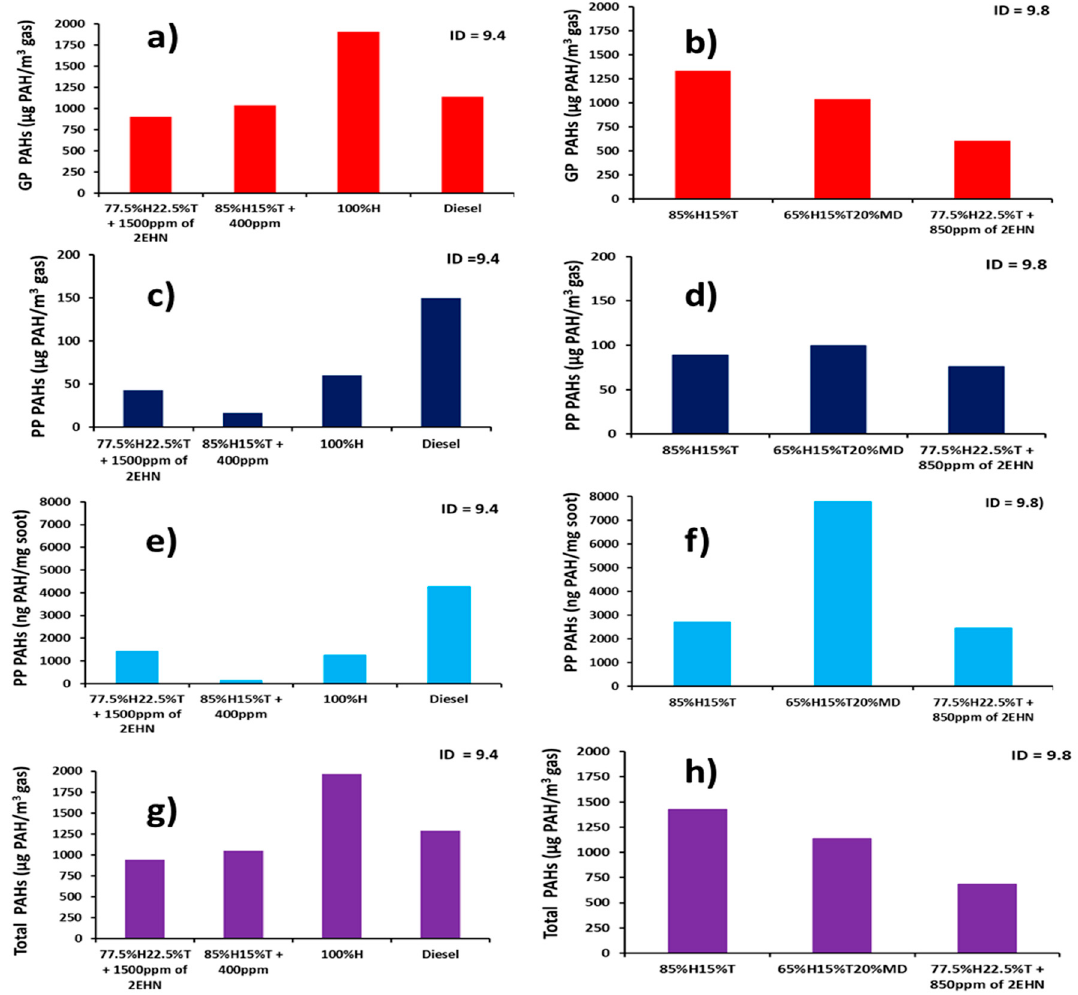
Figure 9. Normalized total PAH concentrations at constant ignition delays: ( a ) Gas Phase PAH at ID = 9.4, ( b ) Gas Phase PAH at ID = 9.8, ( c ) Particle Phase PAH at ID = 9.4, ( d ) Particle Phase PAH at ID = 9.8, ( e ) Particle Phase at ID = 9.4, ( f ) Particle Phase PAH at ID = 9.8, ( g ) total PAH at ID = 9.4 and ( h ) total PAH at ID = 9.8.